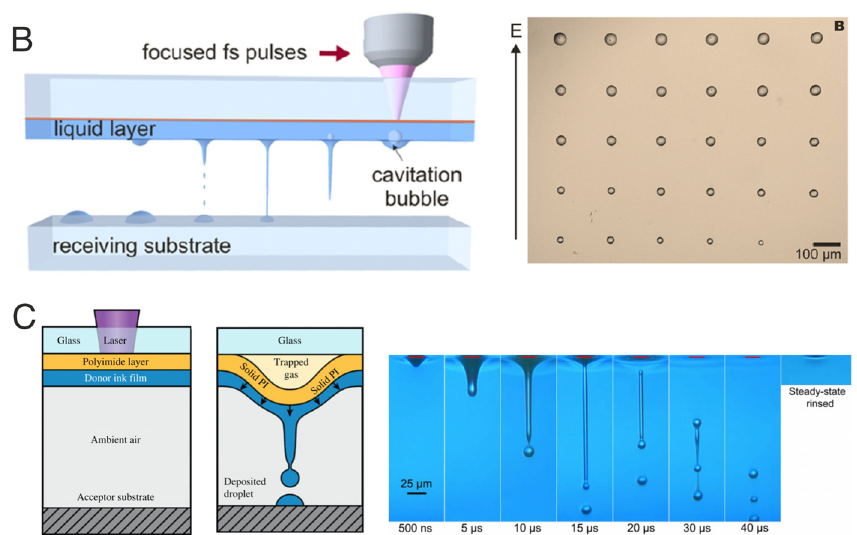
Figure 4. ( A ) No sacrificial layer (the liquid absorbs the laser radiation). Reprinted from [11], copyright (2016), with permission from Elsevier. ( B ) Metallic intermediate layer. Reprinted from [12], copyright (2017), with permission from Elsevier. ( C ) Blister-actuated LIFT based on the use of a polymer absorbing layer. Reprinted/adapted from Ref. [13] (Copyright 2018) with permission from Wiley Books.